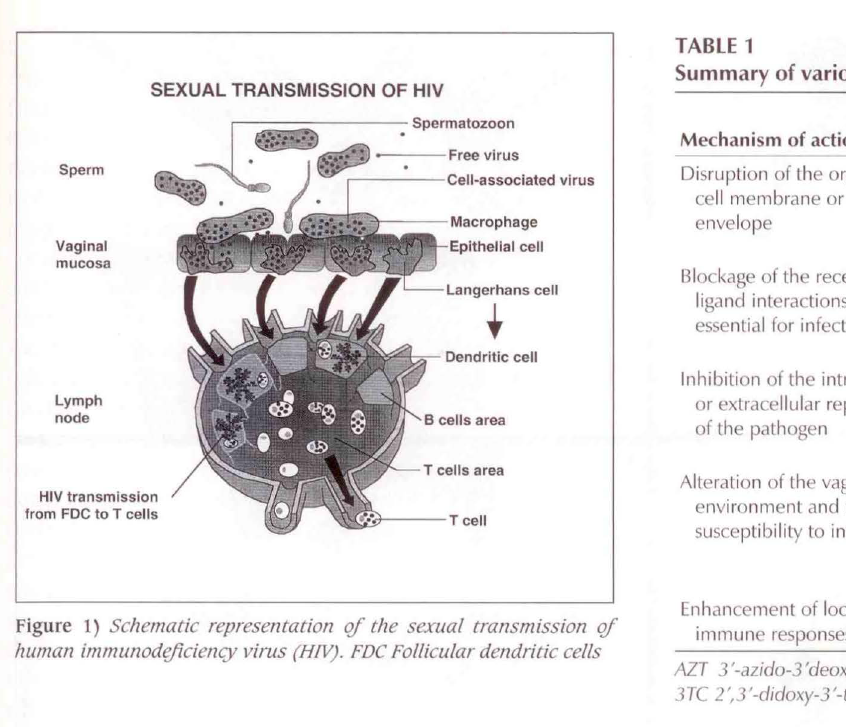
Summary of various mechanisms of action of microbicides Mechanism of